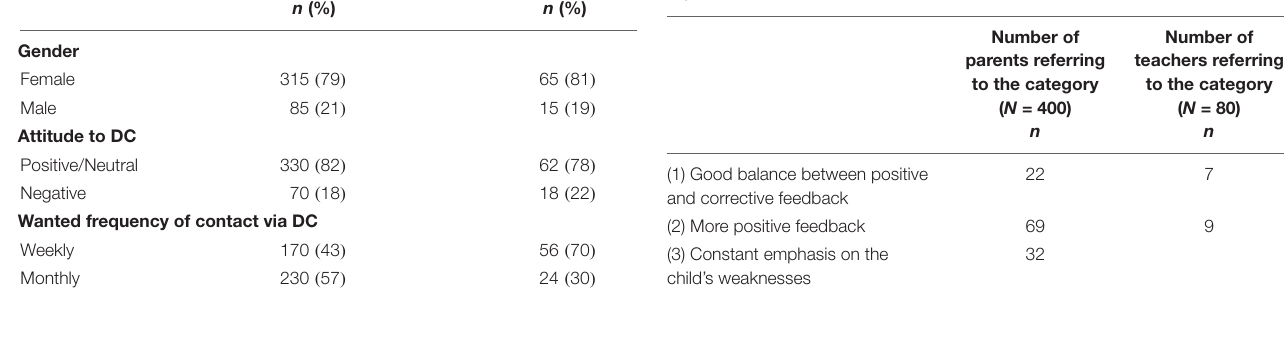
TABLE 3 | Parents’ and teachers’ expectations of how pupil feedback should be expressed in